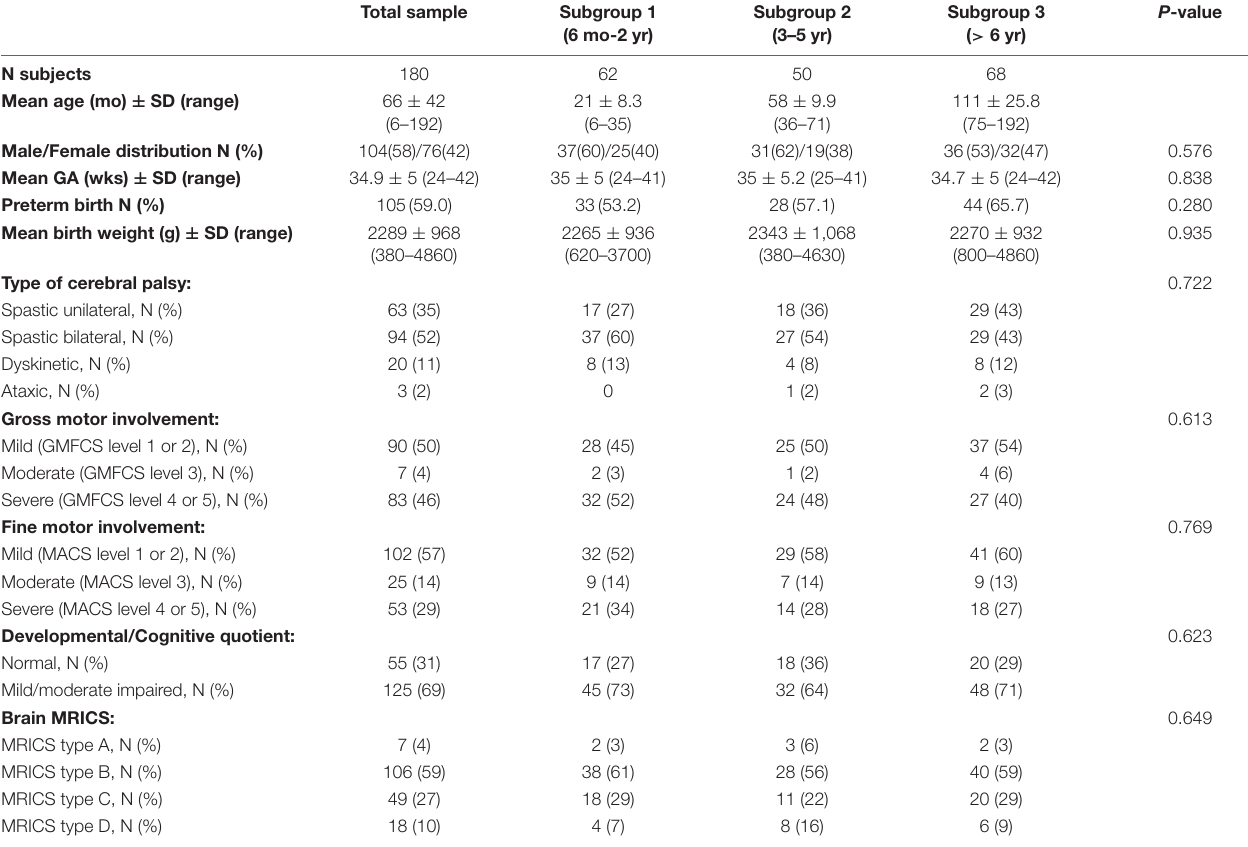
TABLE 1 | Demographic, anamnestic, clinical, and neuroradiological characteristics of the sample and of the age